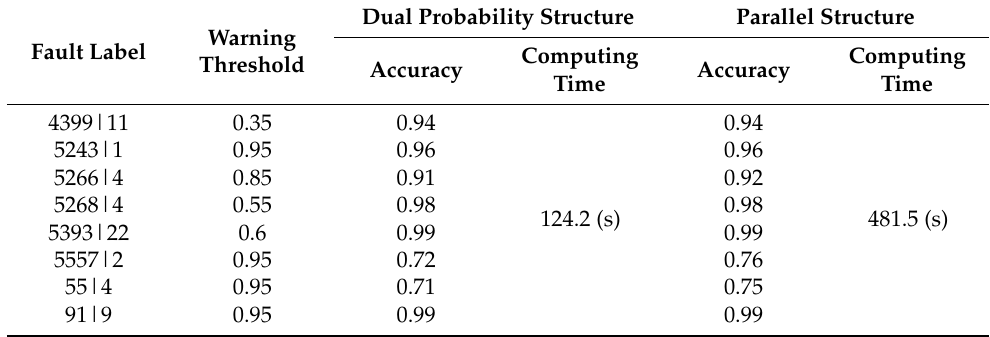
Table 6. Results of the control